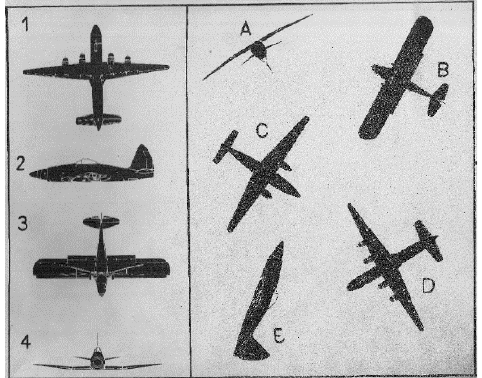
Figure 1. Example layout of various aircraft representa- tion used for T2 test.